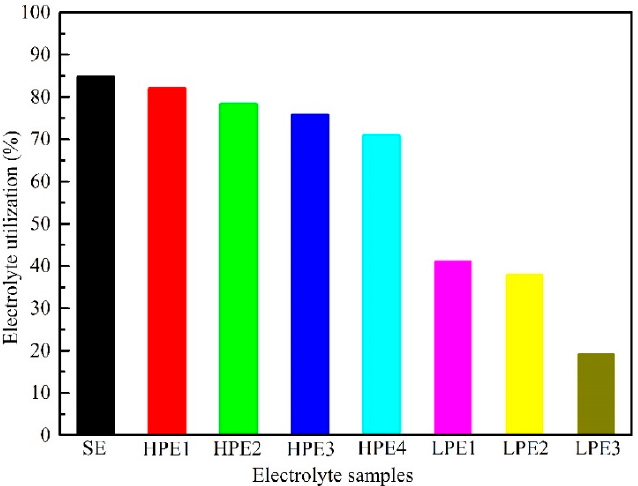
Figure 7. Electrolyte utilization of VRFBs with different electrolyte samples at a current density of 40 mA cm − 2 .